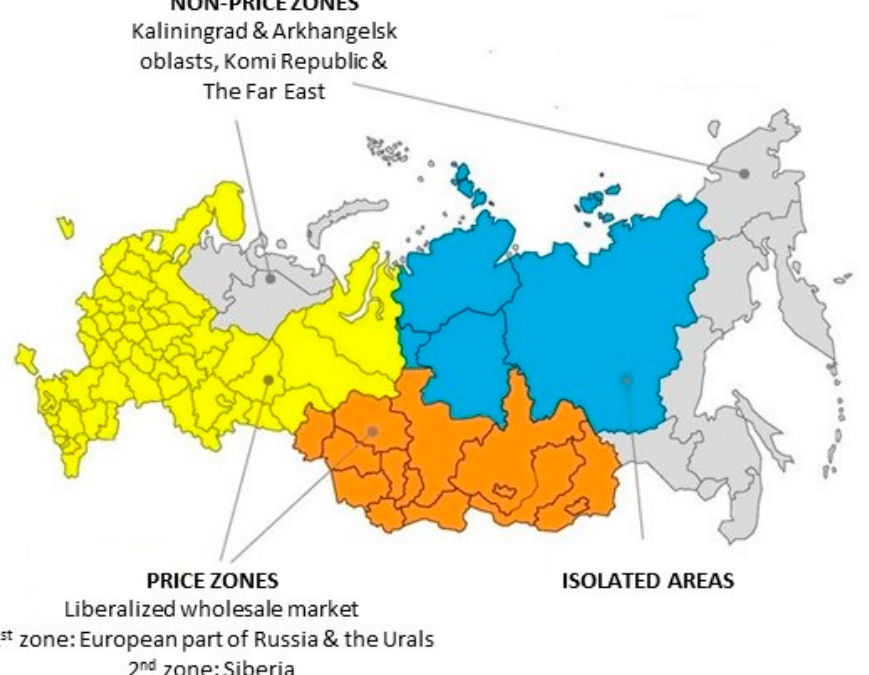
Figure 2. Geography of the Russian electricity and capacity market. Source: own results based on [65].